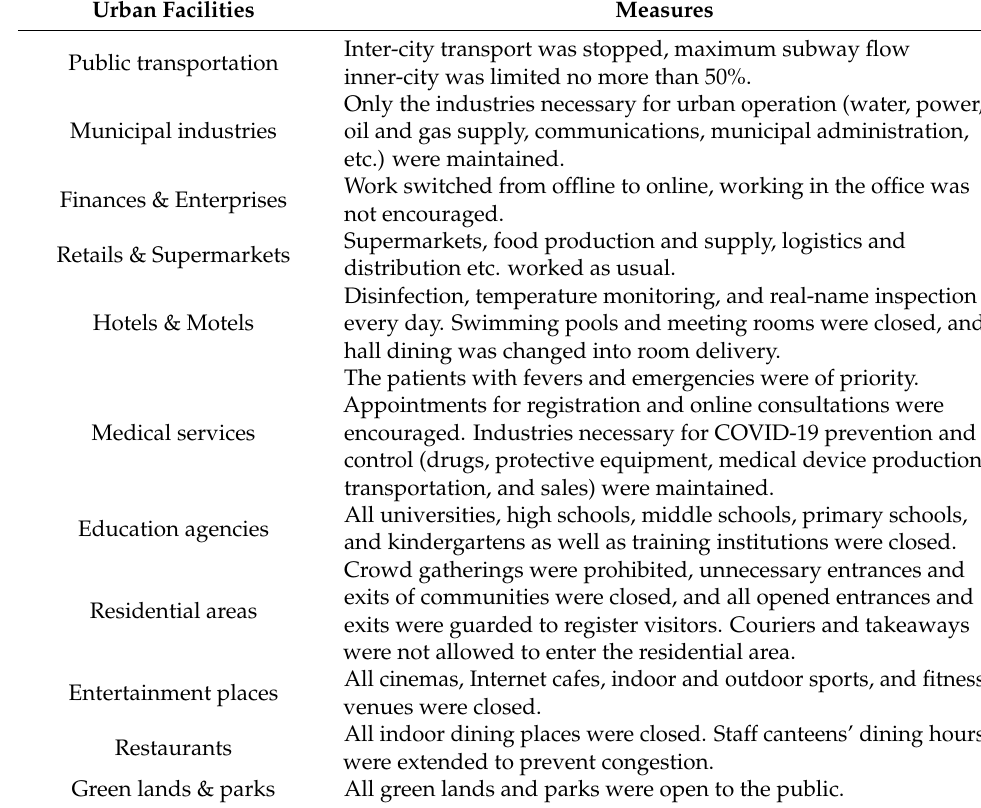
Table 1. The COVID-19 prevention and control measures implemented in urban facilities in